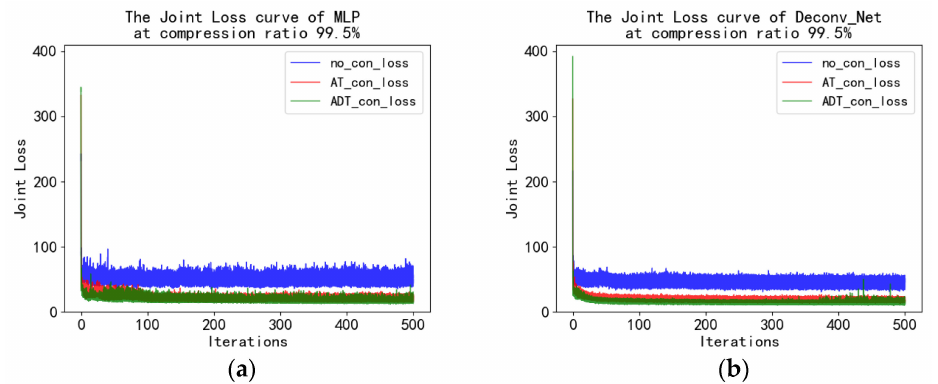
Figure 19. The joint loss curve with the end-to-end MLP model ( a ) and the end-to-end Deconv_Net model ( b ) at a compression ratio of